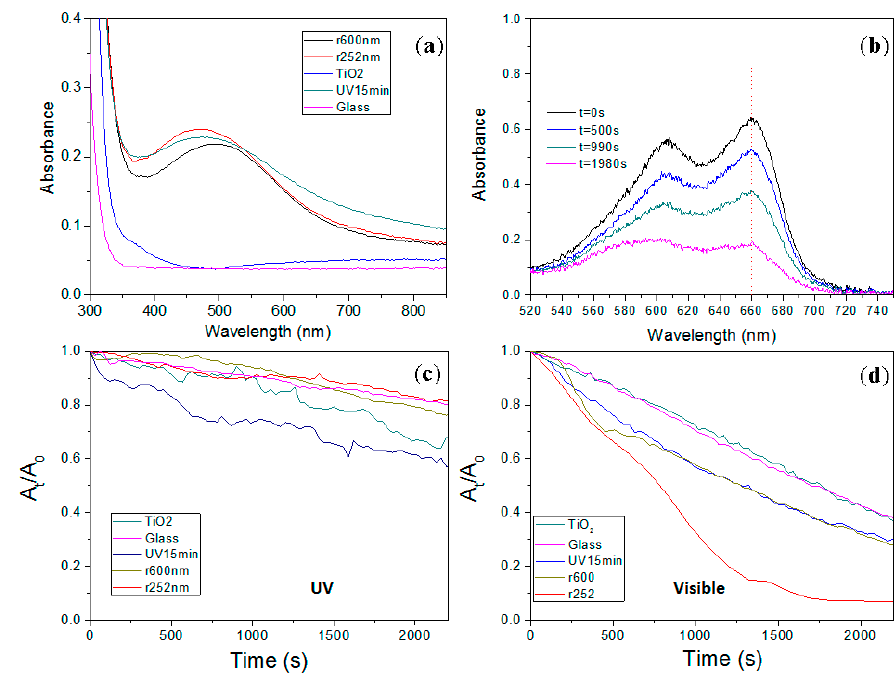
Figure 3. ( a ) Absorbance spectra of glass substrate (glass), TiO 2 , UV15min, r252nm and r600nm samples. ( b ) Absorbance variation of methyl blue (MB) solution during the visible illumination of the sample r600nm. ( c , d ) Absorbance variation at 660 nm normalized by the absorbance at the initial state ( t = 0 s) for the different samples under ultraviolet (UV) or visible illumination, respectively.